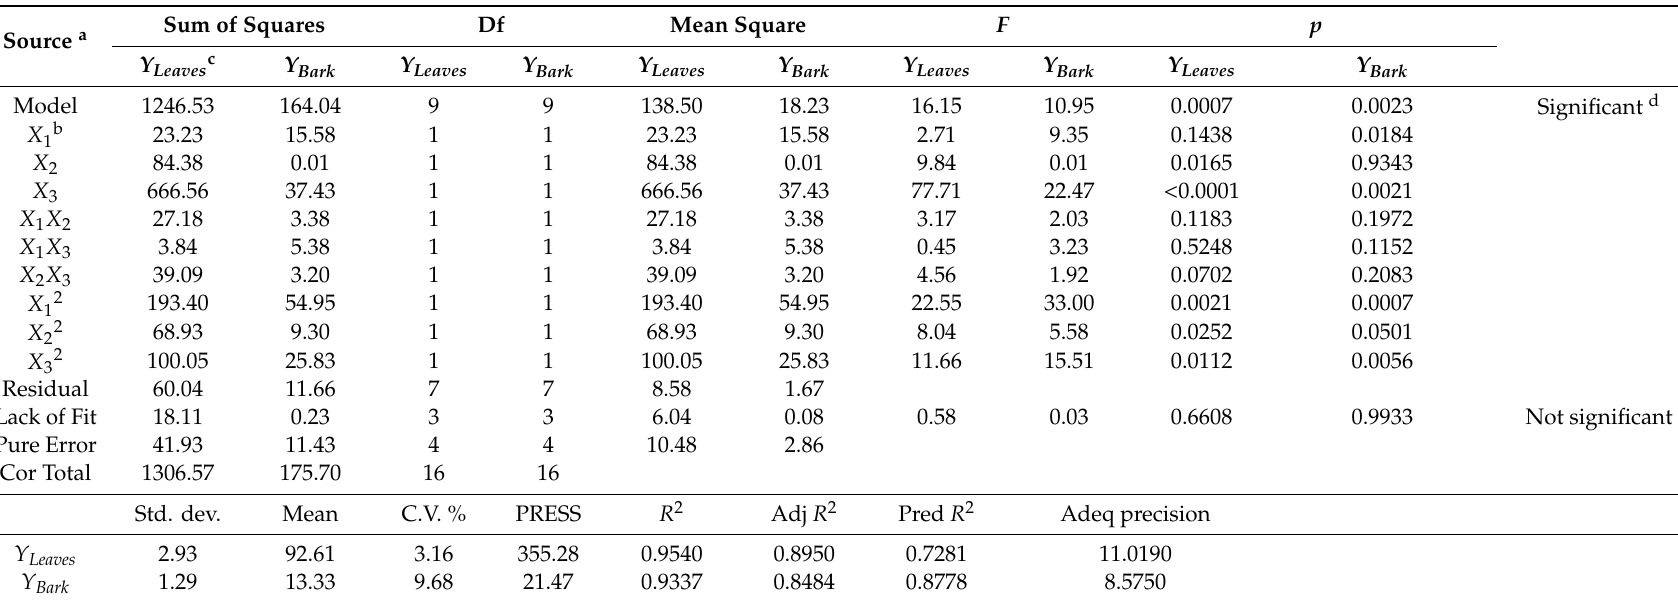
Table 2. Analysis of variance (ANOVA) for response surface quadratic model, and fit statistics for response values a